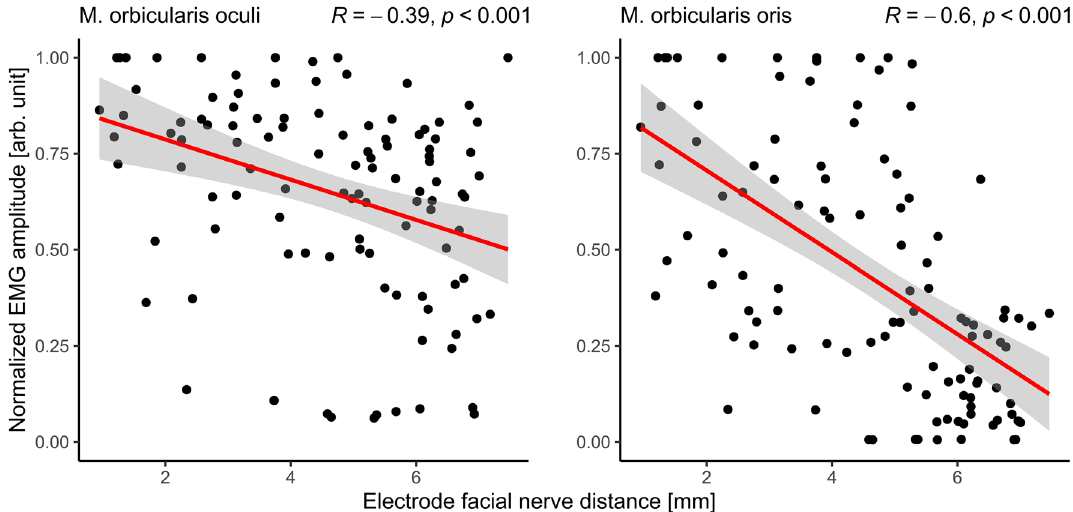
Figure 9. Correlation between the normalized EMG responses of the M. orbicularis oculi (left side) and oris (right side) after full insertion in all subjects and the radiologically measured electrode facial nerve distances. The red line indicates the linear regression of the respective results, the gray shaded area around the regression line indicates the 0.95 confidence interval. R is the Spearman’s correlation coefficient and p is the significance level of the